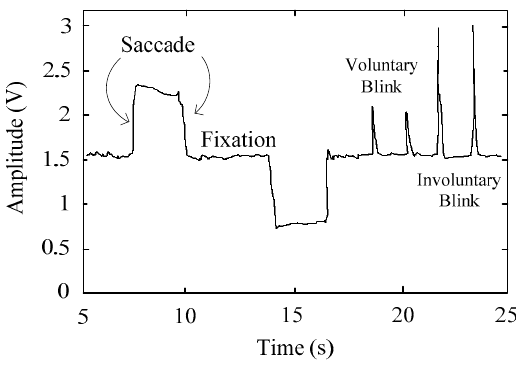
Figure 2. EOG signal showing the basic eye movement types.